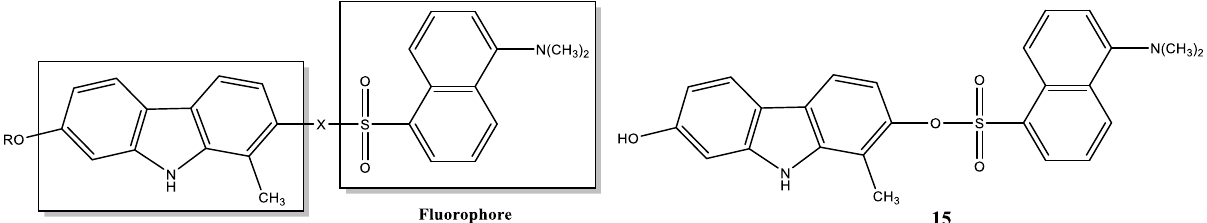
Figure 10. General structure of carbazoles fluorophore and structure of 7-hydroxy-1-methyl-9H-carbazol-2-yl 5-(dimethyl- amino)-naphthalene-1-sulfonate ( 15 ).